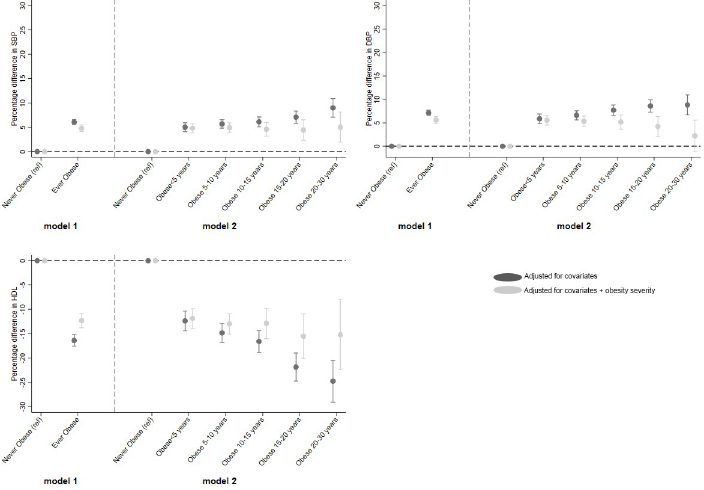
Fig 3. Association between ever obese and categories of obesity duration (versus never obese) and SBP, DBP, and HDL-C. DBP, diastolic blood pressure; HDL-C, high-density-lipoprotein cholesterol; SBP, systolic blood